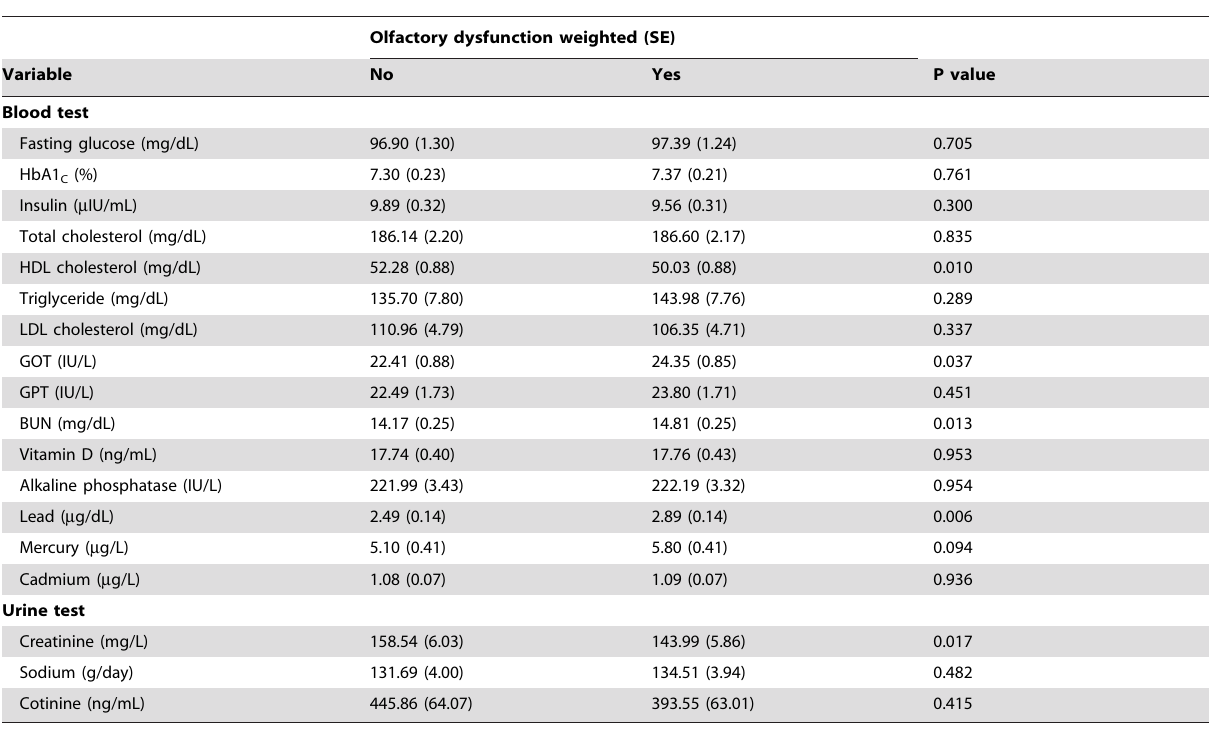
Table 3. Comparison of blood/urine tests between normosmic and hyposmic participants.